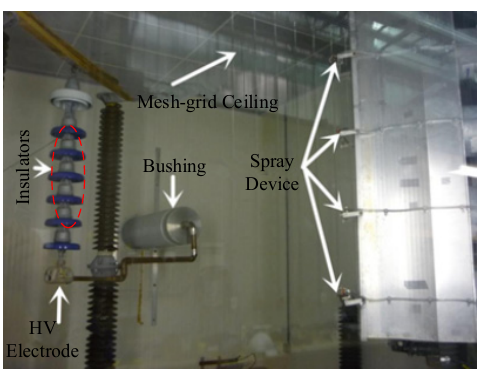
Figure 1. Artificial cold-climate room.